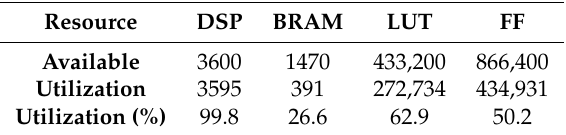
Table 3. Field programmable gate array (FPGA) resource